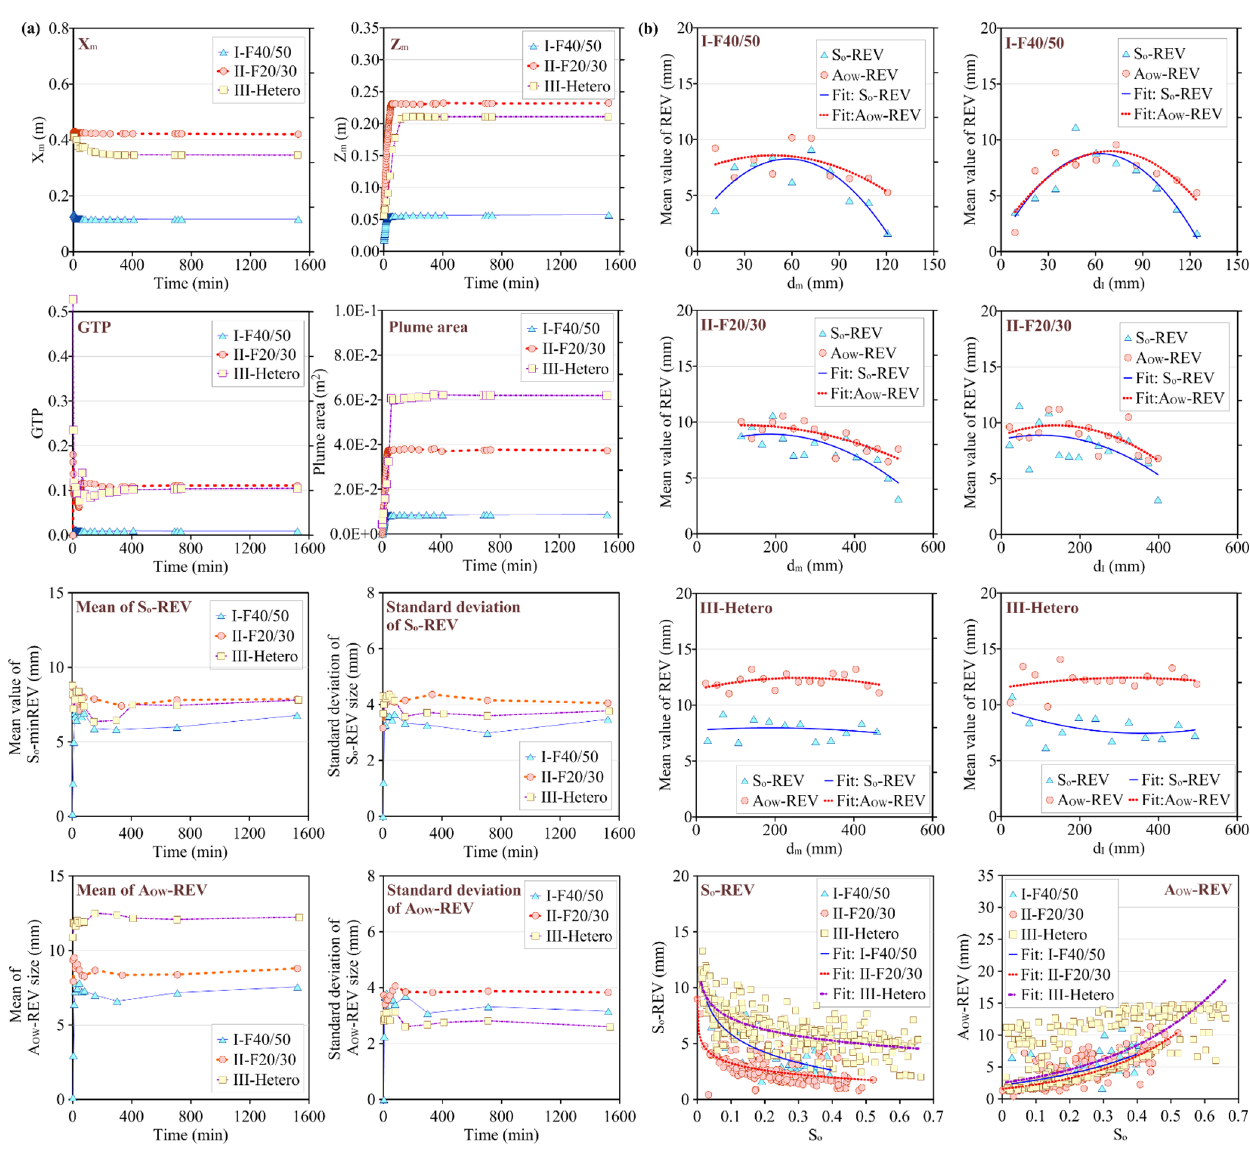
Figure 7. (a) The mass center coordinate of the PCE plume, GTP, plume area and the mean and standard deviation of S o -REV and A OW - REV during 0–1523min; (b) the change in average REV size as the distance d I , d m increases and the fitted relationship between REV sizes and S o for Experiments I and